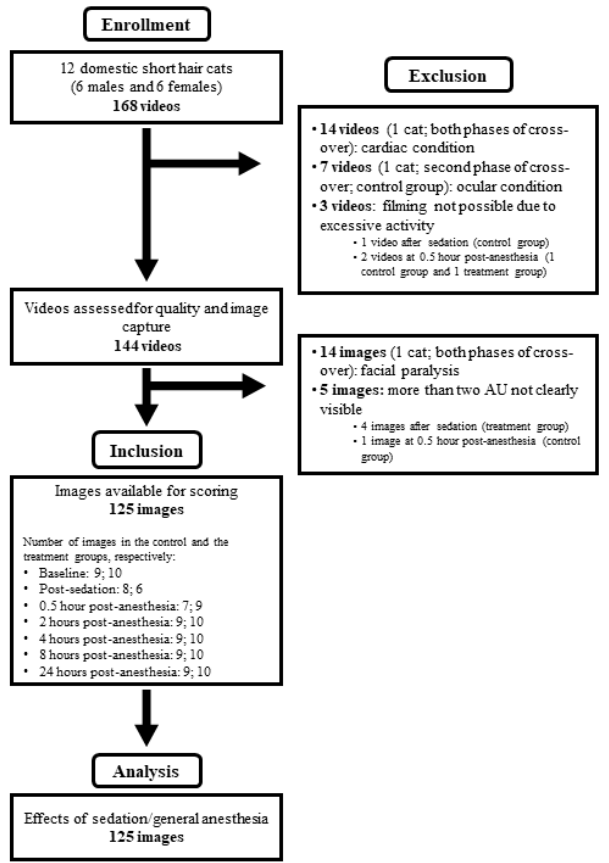
Figure 2. Flowchart of images captured from 12 cats involved in the study of the effects of sedation and general anesthesia on the Feline Grimace Scale © scores. AU : action unit.